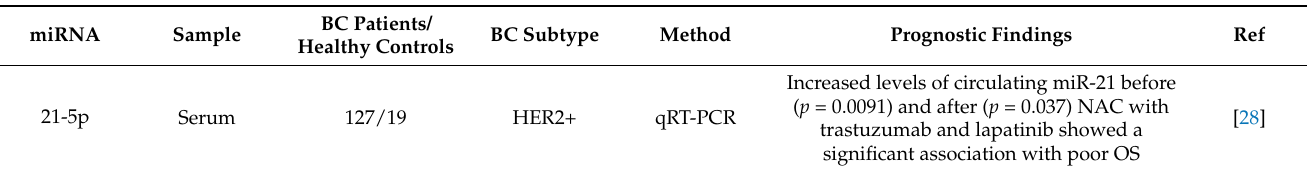
Table 4. Main findings on circulating miRNAs as prognostic markers in BC patients undergoing